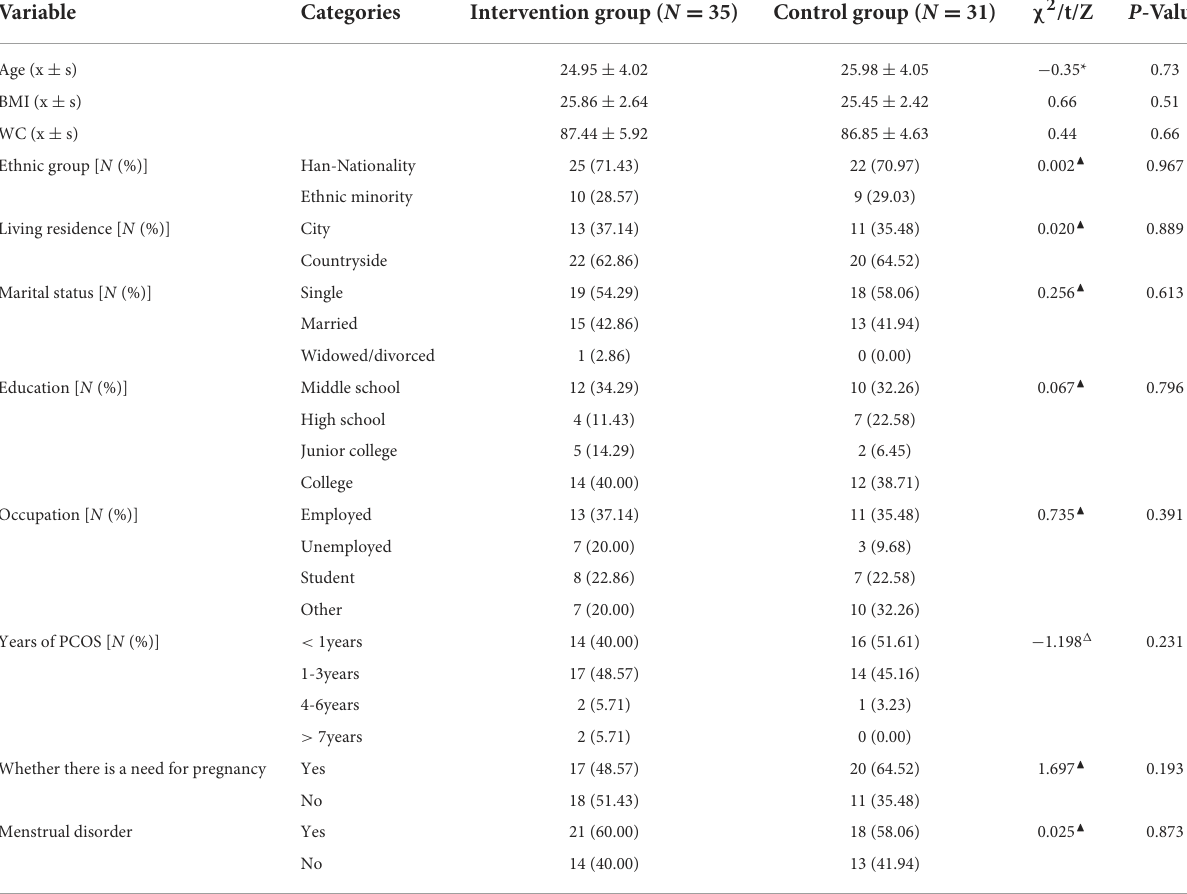
TABLE 1 Comparison of general data between two groups of patients.